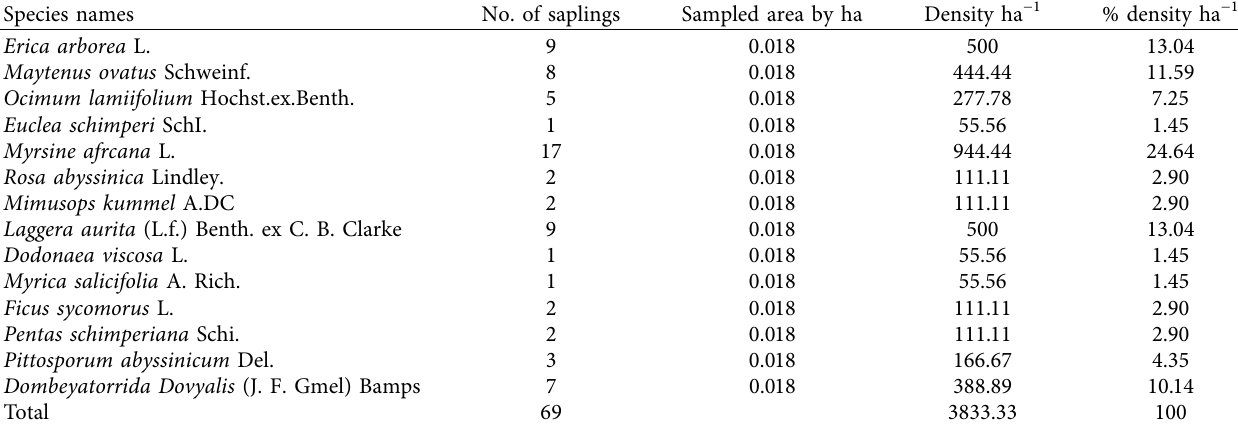
Table 6: Abundance and density per hectare of saplings of Zijje Maryam Church Forest.